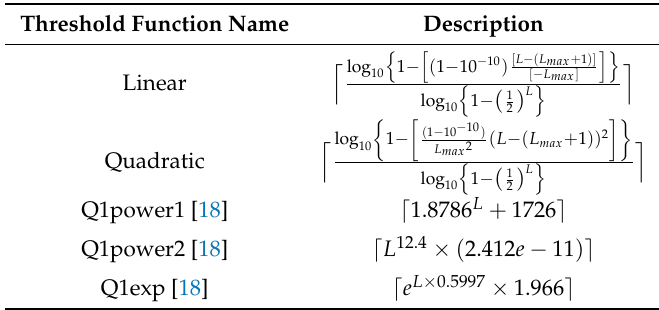
Table 4. Threshold